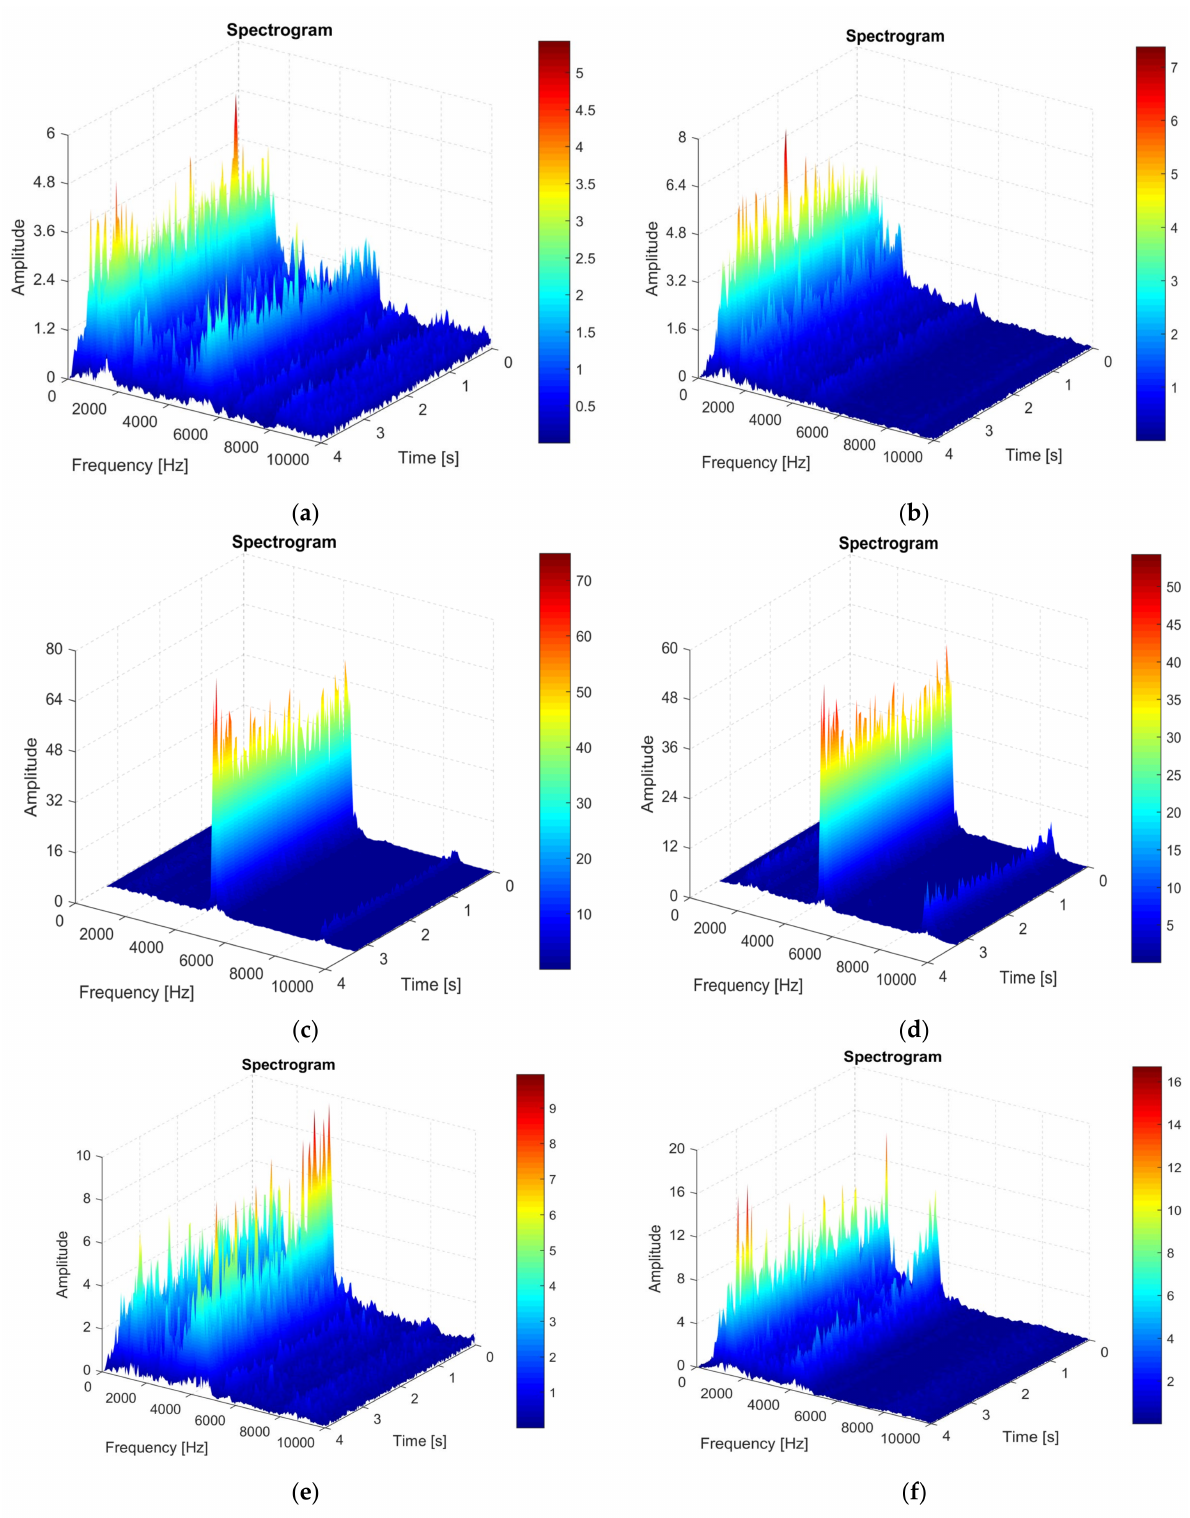
Figure 8. Vibration spectrogram recorded during machining: ( a ) in the Z direction in the case of machining with the cutting tool T01; ( b ) in the X direction in case of machining with the cutting tool T01; ( c ) in the Z direction in case of machining with the cutting tool T02; ( d ) in the X direction in the case of machining with a T02 cutting tool; ( e ) in the Z direction in the case of machining with the cutting tool T03; ( f ) in the X direction in the case of machining with the cutting tool